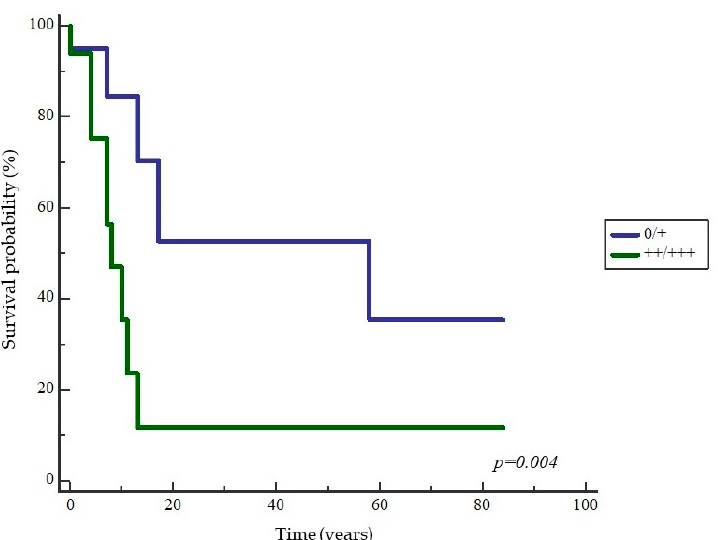
Figure 14. Kaplan–Meier survival curve in relation to nEGFR expression in patients with OSCC. The curve shows significantly shorter survival of patients with moderate and strong expression of nEGFR in tumor tissue ( p = 0.004).